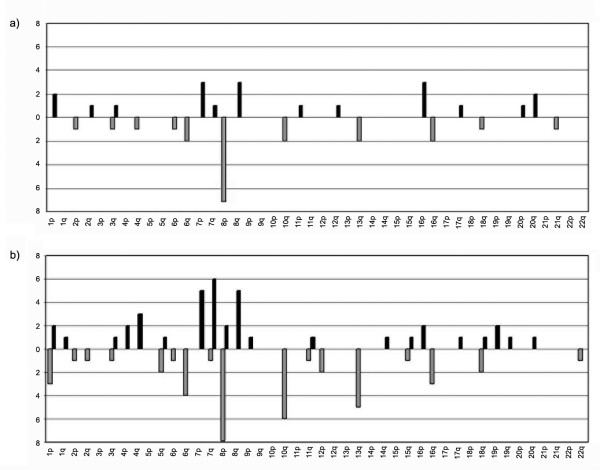
Summary of chromosomal losses and gains in a) HPIN (n = 7) and b) CaP (n = 8). Number of samples of each type with gain or loss of the chromosome arm is shown by black and grey bars, respectively.